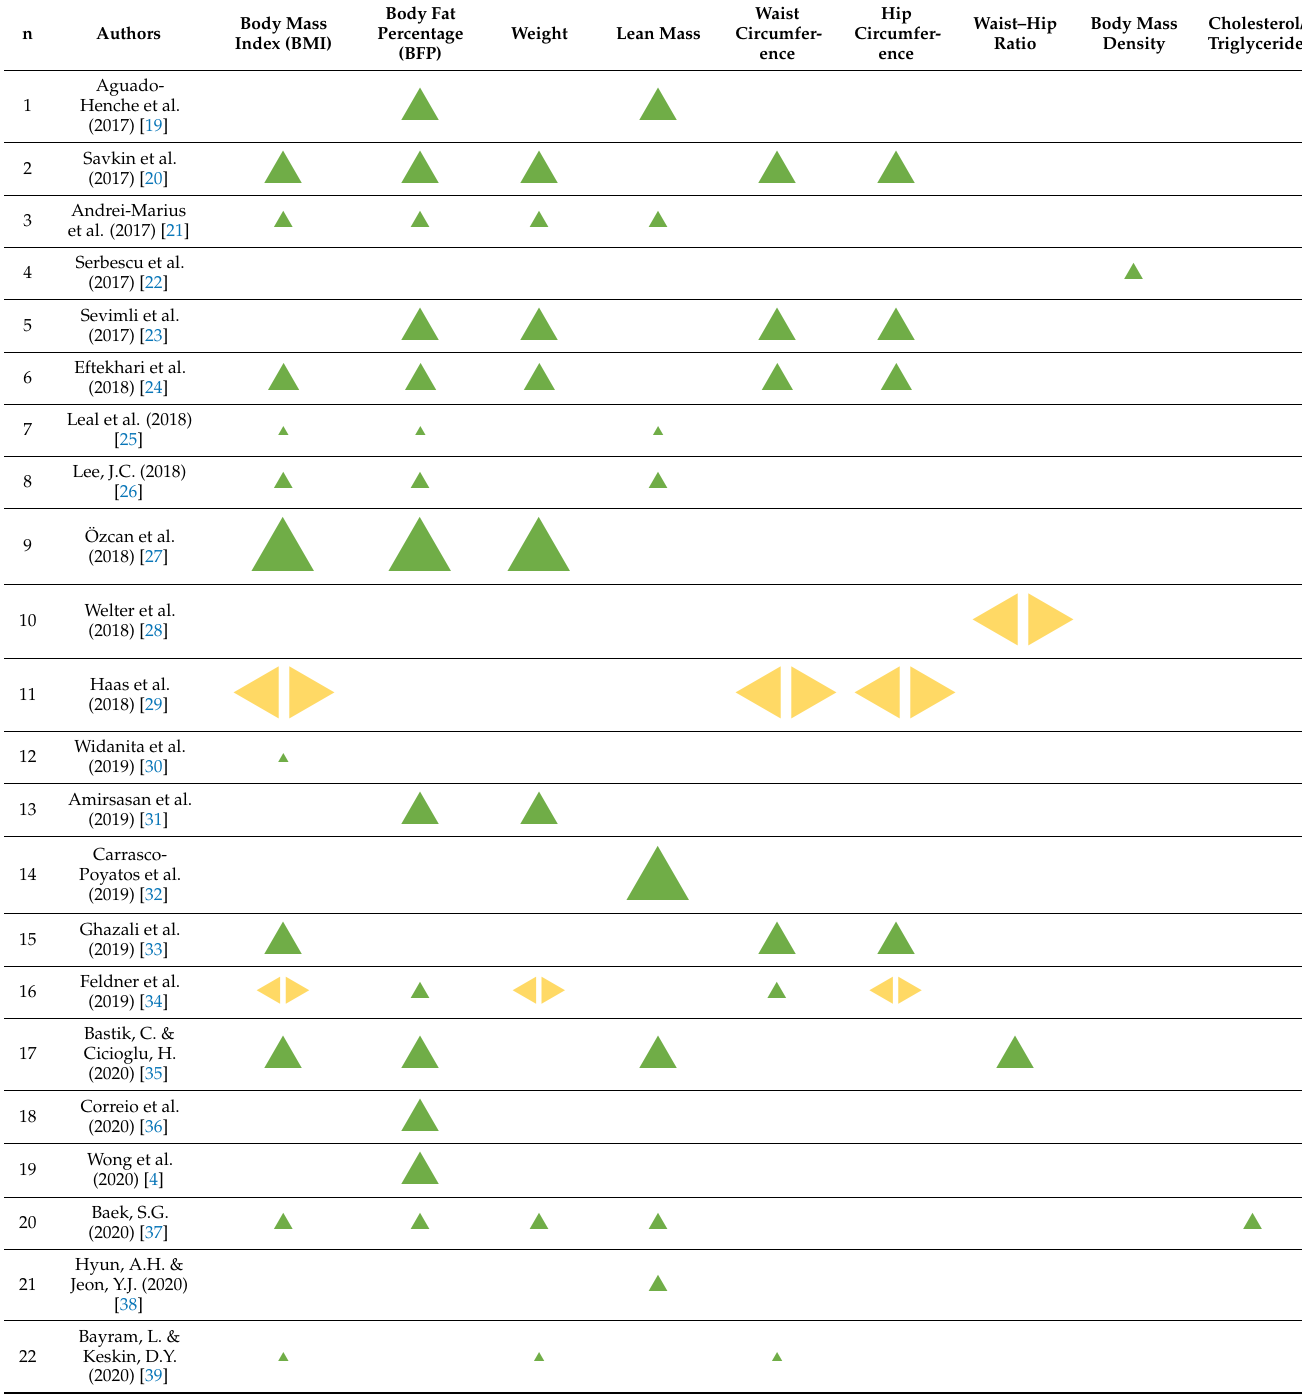
Table 2. Effect direction plot and signal test.